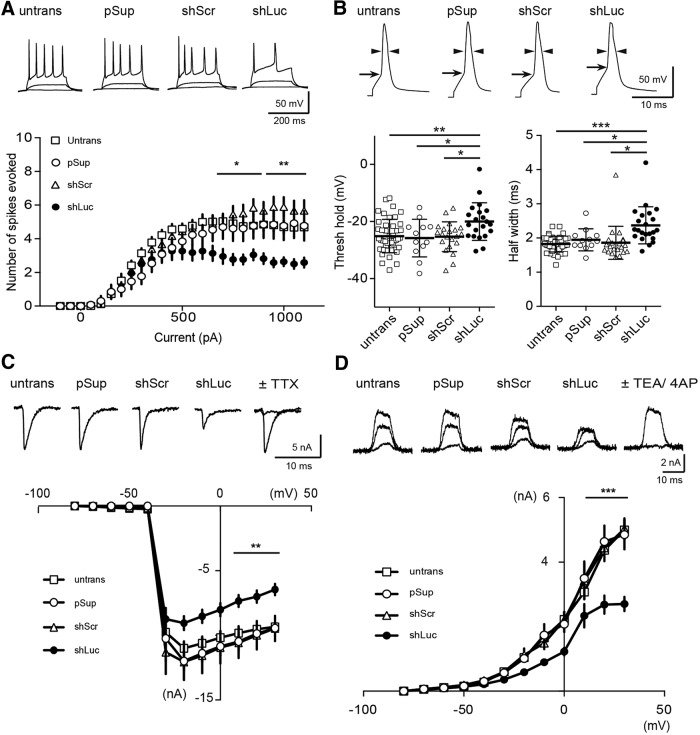
Reduced membrane excitabilities in shLuc-transfected CA1 pyramidal neurons. A, Effect of shRNA overexpression on neuronal excitability. An empty vector (pSup), shLuc, or shScr was transfected together with pCAG-EGFP. Top, Sample traces from untransfected and transfected CA1 pyramidal neurons in organotypic hippocampal slice cultures. The superimposed traces were elicited by current injections of 0, 100, and 500 pA for 200 ms. Bottom, Summary graph of the frequency of APs in untransfected and transfected neurons. The input–output relationship [number of spikes elicited versus amount of current injection (200-ms duration)] was plotted for untransfected and transfected neurons. Neurons were held at resting membrane potentials (−56.8 mV ± 0.57, n = 100 cells, 9 mice). Number of cells tested: untrans, 45 cells from eight mice (45/8); pSup, 13/7; shScr, 20/5; and shLuc, 22/9. B, Effect of shRNA overexpression on AP kinetics. Top, Sample traces from CA1 pyramidal neurons untransfected and transfected with the three different plasmids. Single APs were induced by current injection (100 pA for 4 ms) and threshold (horizontal arrows) and half width of AP determined by vertical double arrow heads in trans- and untransfected neurons were measured. Bottom, Summary graph of the threshold (left) and half width (right) of single AP in untransfected and transfected neurons. Number of cells tested: untrans, 45 cells/8 mice (45/8); pSup, 13/7; shScr, 20/5; shLuc, 22/9. C, top, Sample traces of sodium currents recorded from untransfected and transfected CA1 pyramidal neurons. Note that these currents were completely blocked by TTX (right). Bottom, Summary graph of the sodium currents in untransfected and transfected neurons. Neurons were voltage-clamped at –80 mV and depolarized from –80 to 30 mV (10-ms duration). Number of cells: untrans, 16 cells/5 mice; pSup, 10/5; shScr, 10/5; shLuc, 14/6. D, top, Sample traces of potassium currents recorded from untransfected and transfected CA1 pyramidal neurons. Note that these upward currents were completely blocked by TEA and 4-AP (right). Bottom, Summary graph of the potassium currents in untransfected and transfected neurons. Neurons were voltage-clamped at –80 mV and depolarized from –80 to 30 mV (10-ms duration). Number of cells tested: untrans, 15 cells/4 mice; pSup, 13/3; shScr, 7/3; shLuc, 9/3.